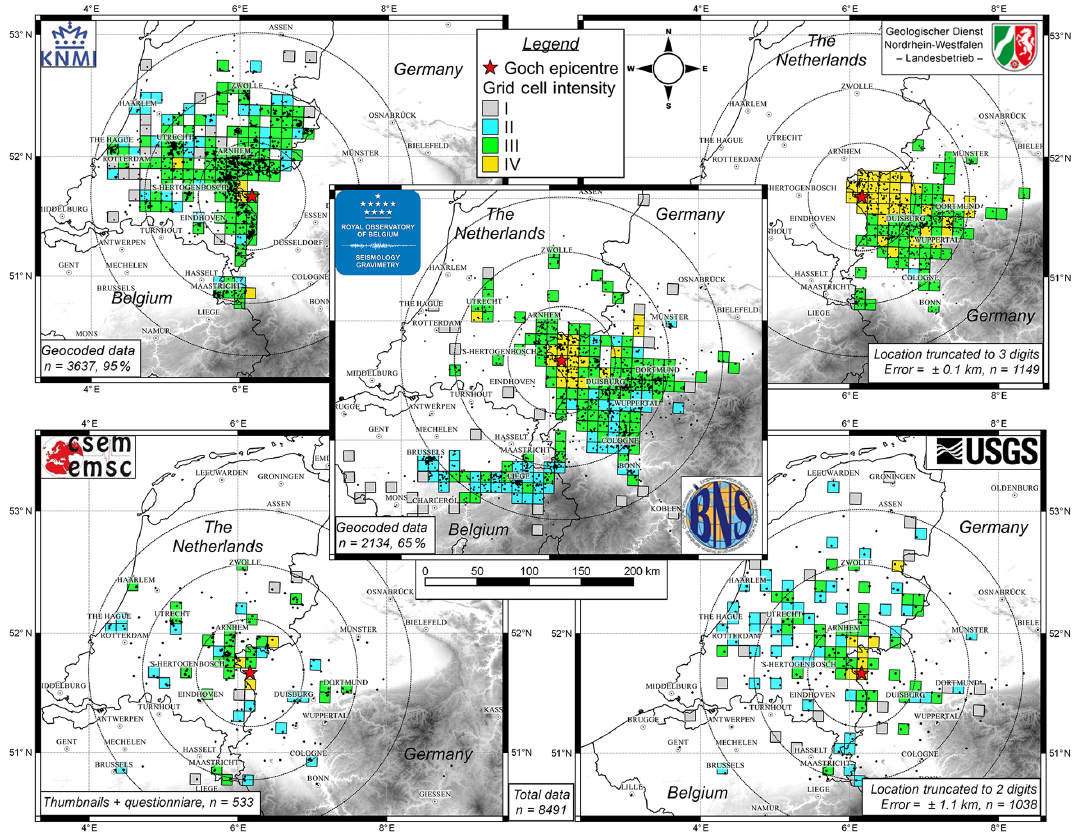
Figure 4. Fragmentation of macroseismic data of the 2011 Goch earthquake. Transfrontier collaborations (ROB-BNS) and international institutes (USGS, EMSC) that provide an English or a multilanguage inquiry cover a wider geographical spread than national inquiries (KNMI, NRW-GD). ROB-BNS and KNMI datasets are geocoded (percentage indicates the amount of data used in the grid cell analysis). Grid cell size is 100km 2 . Only cells with at least three entries are coloured. Circles represent 50, 100 and 150km epicentral